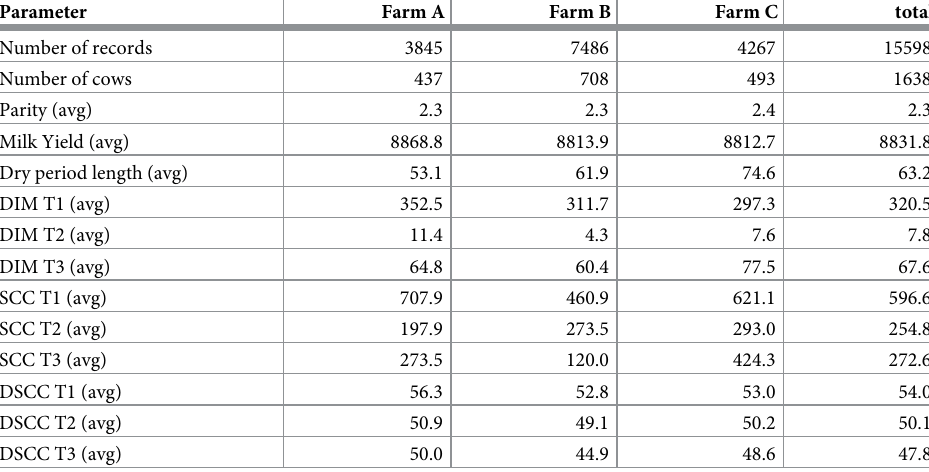
Table 2. Descriptive statistics of the farms enrolled in the study.